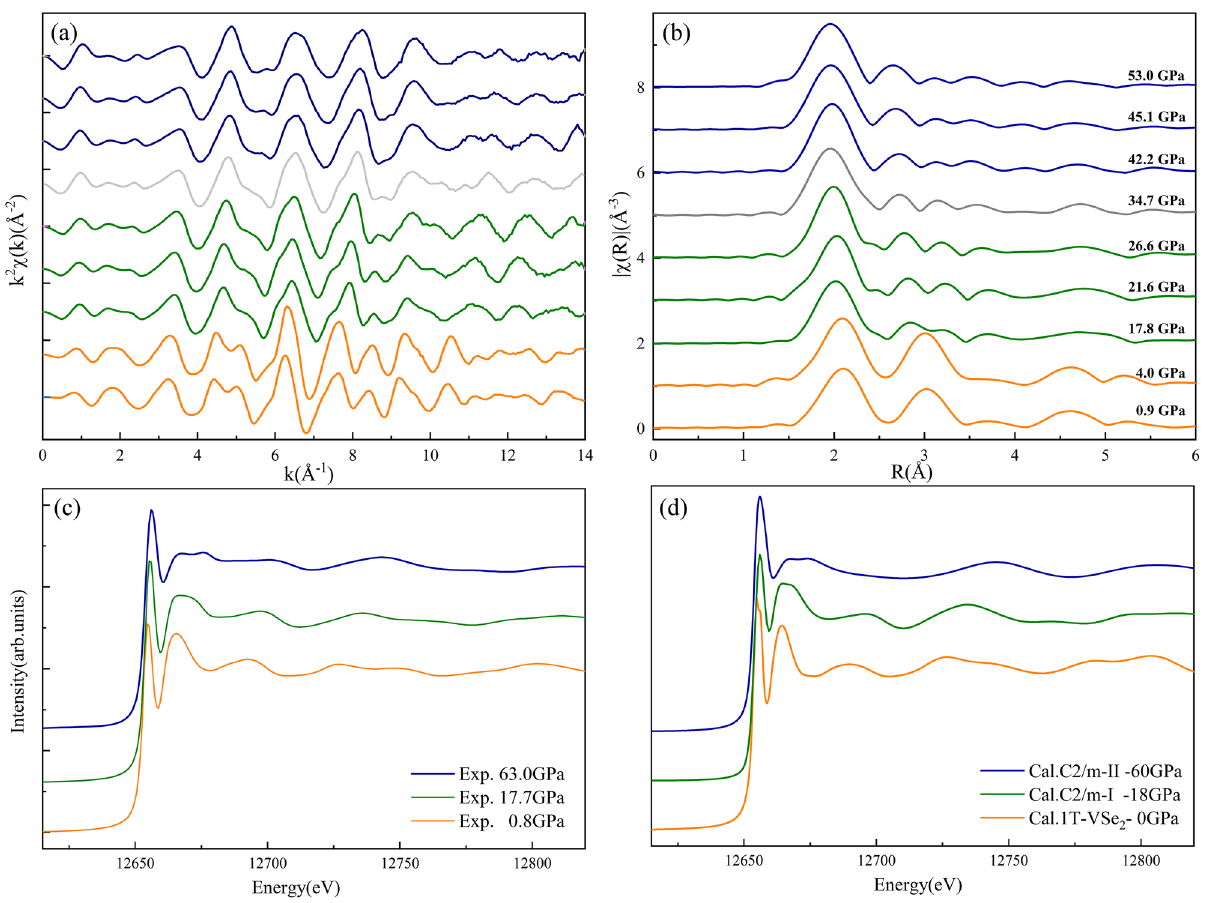
Figure 7. ( a ) The Se K -edge EXAFS k 2 χ ( k ) oscillation signals of bulk VSe 2 collected at different pressures in the range of 0–53.0 GPa. ( b ) The corresponding Fourier-transformed magnitude for bulk VSe 2 . ( c ) Normalized Se K-edge XANES experimental spectra of bulk VSe 2 under the pressure of 0.8, 17.7, and 63.0 GPa. ( d ) The simulated spectrum of VSe 2 using FDMNES code based on the 1 T , C2/m -I, and C2/m -II